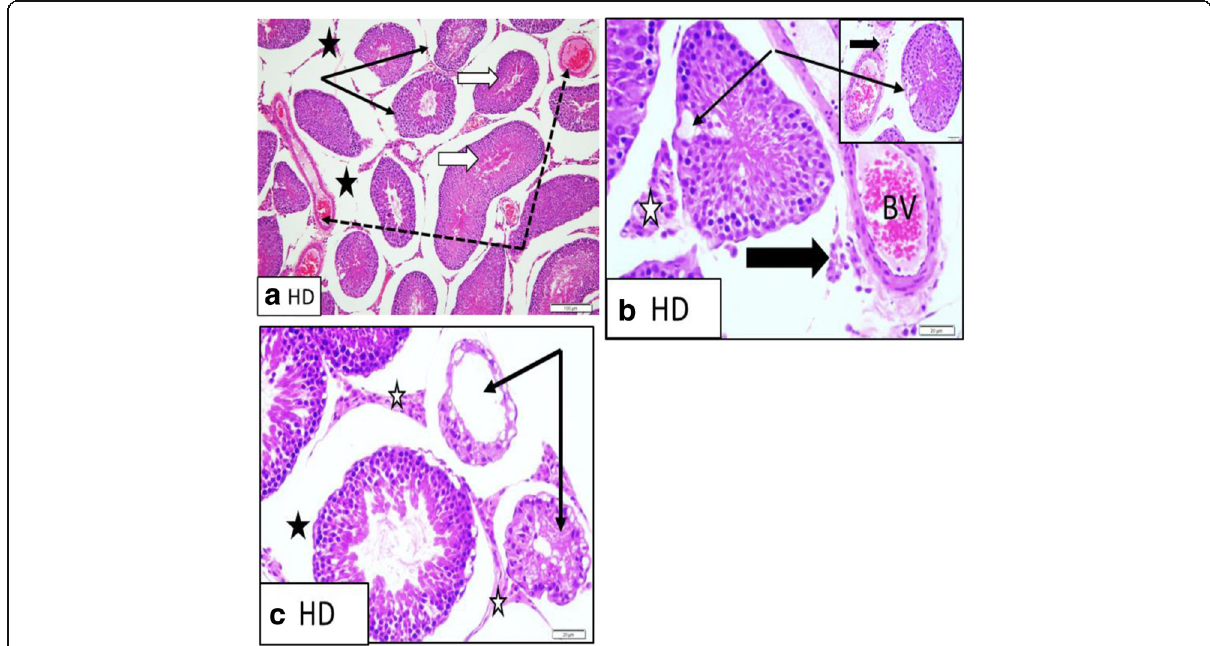
Fig. 7 Sections from the rat testis administered with high-dose hair dye for 8 days show the following: a more shrinkage (black arrows) and de- formity (white arrows) of seminiferous tubule, wide interstitial spaces (black stars), and dilatation and congestion of blood vessels (dotted arrows) (H-E, × 200). b Magnified part to show degenerative changes in basal cells. The nuclei of other germ cells are dark stained and pyknotic (black arrows) marked congestion of blood vessels (BV) with perivascular inflammatory cells (thick black arrow) and atrophy and degeneration of Leydig cells (white star) (H-E, × 400). c Some tubules showed marked degeneration and absence of most germ cells (black arrows); the rest showed no mature sperms. Leydig cells looked small and degenerated (white and black stars) (H-E, ×